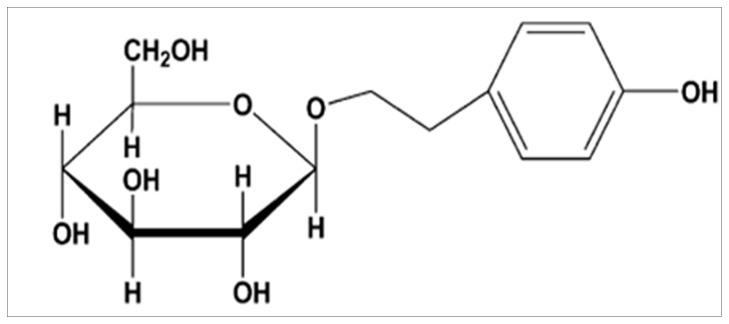
Chemical structure of salidroside.